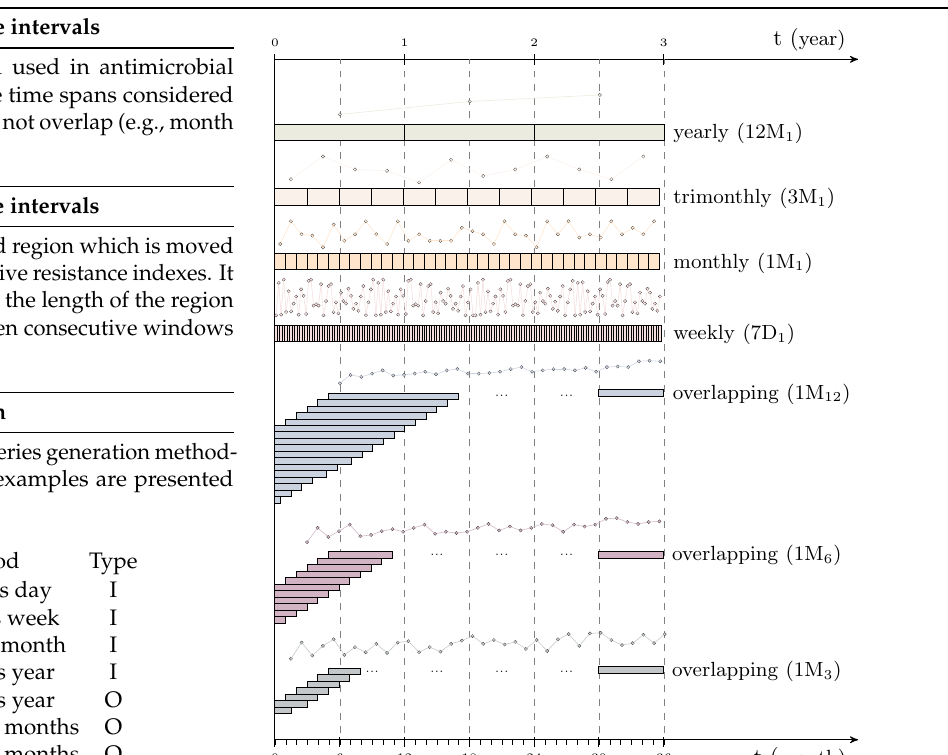
Table 1. Description of strategies to generate resistance time